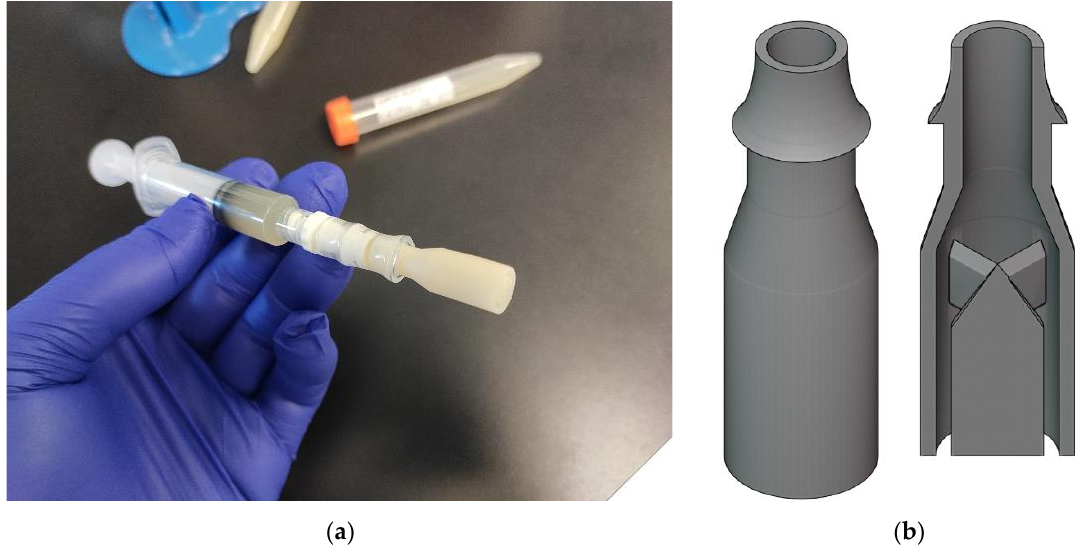
Figure 7. Extrusion attachment for a standard luer-lock syringe ( a ) Syringe with ureter extrusion nozzle. A Collagen-Alginate mixture is loaded. ( b ) The 3D model of the extrusion attachment, the right view has a cutaway showing the internal structure.